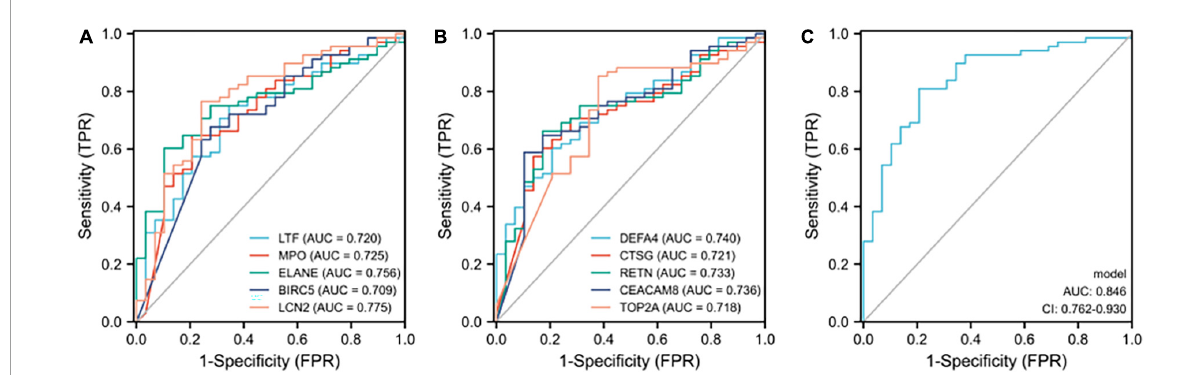
FIGURE8 ROC curves of the 10 hub genes in identifying renal involvement patients with high disease activity (SLEDAI > 15). (A,B) ROC curves of the 10 hub genes. (C) ROC curve of the combination model of the 10 hub genes. The combination model was 14.6627 + –0.3795 ∗ DEFA4 + 0.2401 ∗ CTSG + –0.0942 ∗ RETN + –0.0114 ∗ CEACAM8 + –0.2822 ∗ TOP2A + 0.5422 ∗ LTF + 0.1112 ∗ MPO + –0.1143 ∗ ELANE + –0.8064 ∗ BIRC5 + –1.0725 ∗ LCN2. The AUC of the combination model was 0.846 and the 95% confidence interval (CI) was